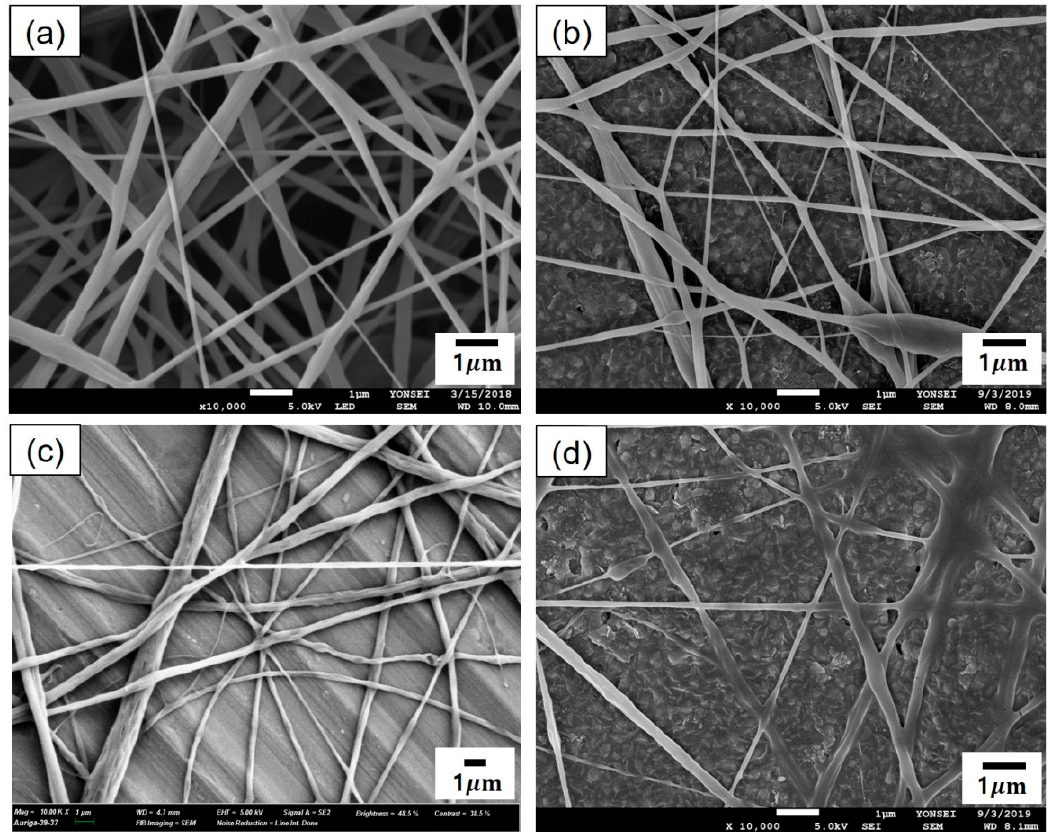
Figure 6. SEM images of cinnamon oil-containing PVA nanofibers produced from emulsion formulations containing high concentrations of cinnamon oil: ( a ) emulsion F (8 wt% of oil, 12 wt% of PVA, and 1.6 wt% of surfactant), ( b ) emulsion G (15 wt% of cinnamon oil, 12 wt% of PVA, and 3 wt% of surfactant), ( c ) emulsion H (20 wt% of cinnamon oil, 12 wt% of PVA, and 4 wt% of surfactant), and ( d ) emulsion I (30 wt% of cinnamon oil, 12 wt% of PVA, and 6 wt% of surfactant). Solution feed rate, applied voltage, needle gauge, and tip-to-collector distance were maintained constant at 0.2 mL/h, 25 kV, 23-gauge, and 20 cm, respectively.